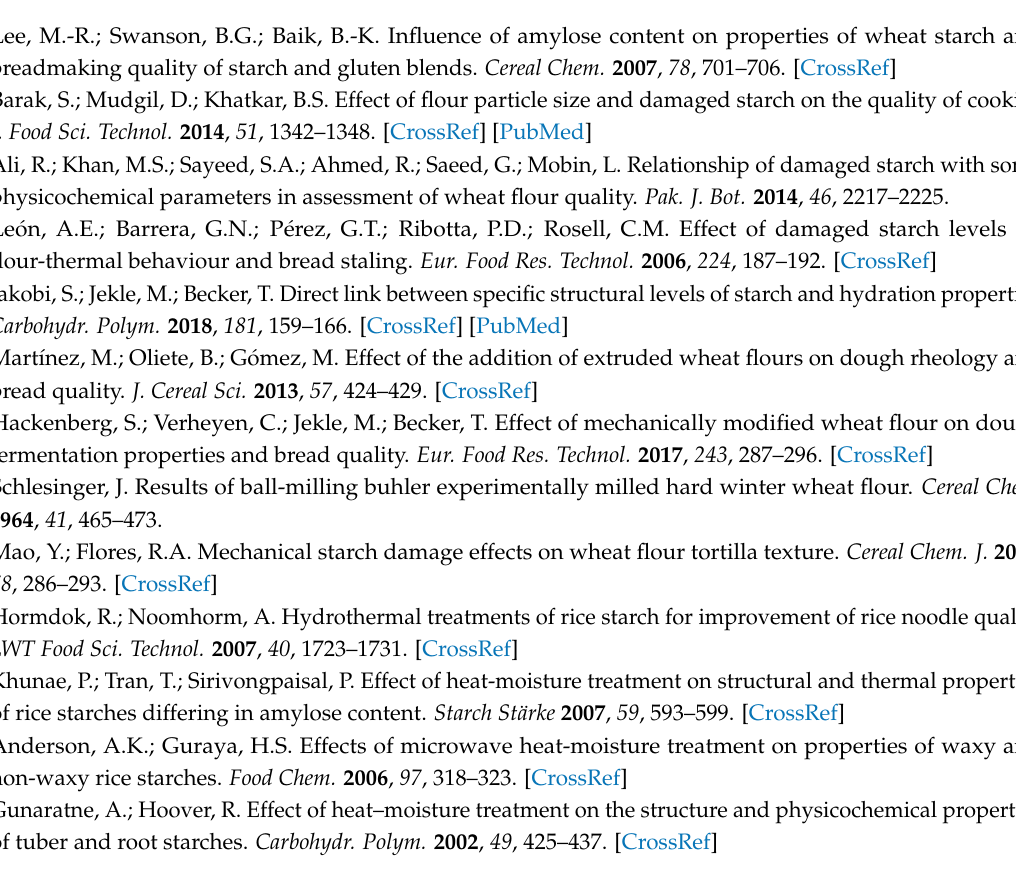
s1. Table S1. Mean ( ± SD) gelatinization enthalpy ∆ H of thermally treated wheat flour and wheat starch. SD = standard deviation; n =